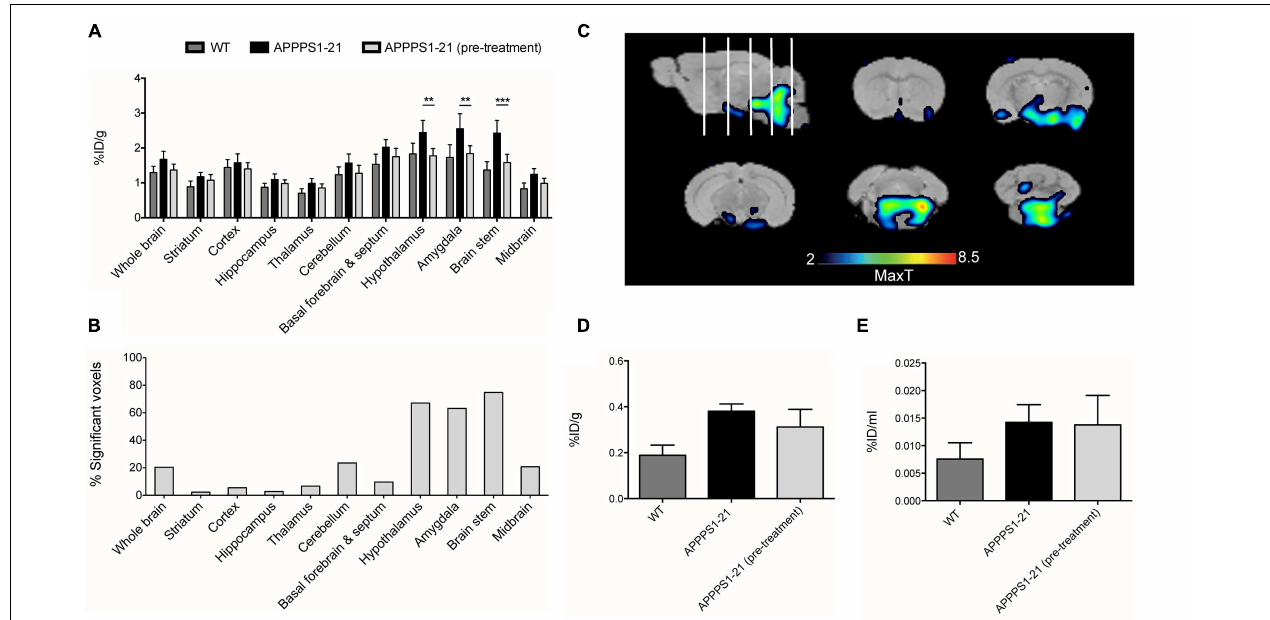
FIGURE 5 | Pre-treatment with non-labeled Df-Bz-JRF/A β N/25 only partially blocks [ 89 Zr]-Df-Bz-JRF/A β N/25 uptake in APPPS1–21 mice. APPPS1–21 mice were treated with 400 µ g of non-labeled Df-Bz-JRF/A β N/25 2 h prior to injection of [ 89 Zr]-Df-Bz-JRF/A β N/25. Brain retention was assessed at 4 days pi. Graph (A) depicts VOI analysis of the µ PET imaging, data is presented as mean + SD. Graph (B) shows voxel-wise analysis, data is presented as the % of each brain region that was significantly changed (decrease). Image (C) is statistical T-maps depicting regions of significantly reduced tracer retention in pre-treated versus untreated APPPS1–21 mice. Radioactivity was measured ex vivo by (D) γ –counting and (E) autoradiography. Data is presented as the average ± SD. Student’s t -test, ∗∗∗ p < 0.001, ∗∗ p <